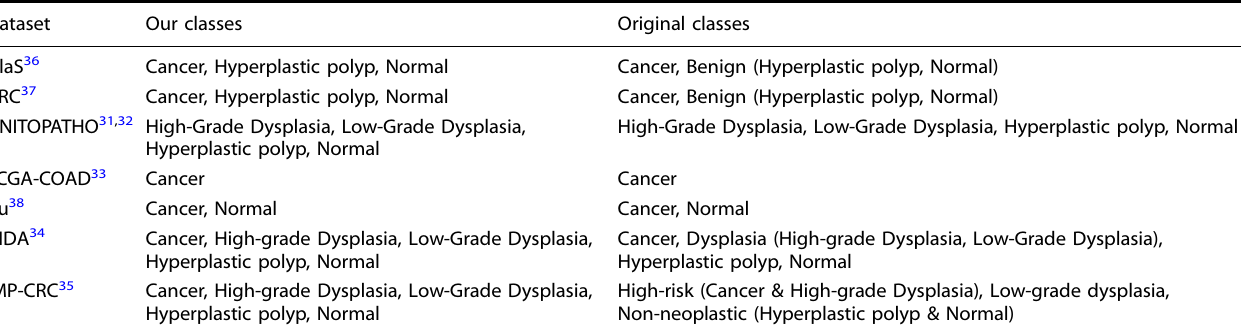
Table 5. The mapping adopted on the publicly available